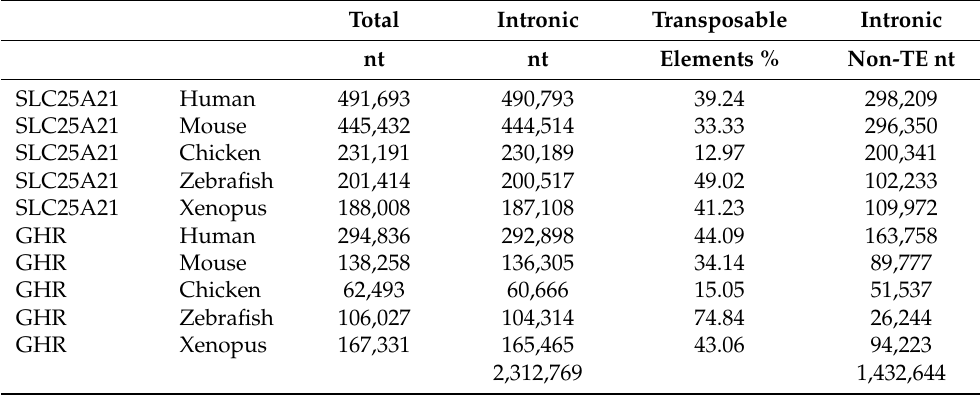
Table 3. Total: total number of nucleotides (start to stop codons); Intronic: number of intronic nu- cleotides; Transposable Elements: % of nucleotides of transposable elements over the total intronic nucleotides; Intronic Non-TE: intronic nucleotides minus TE nucleotides.